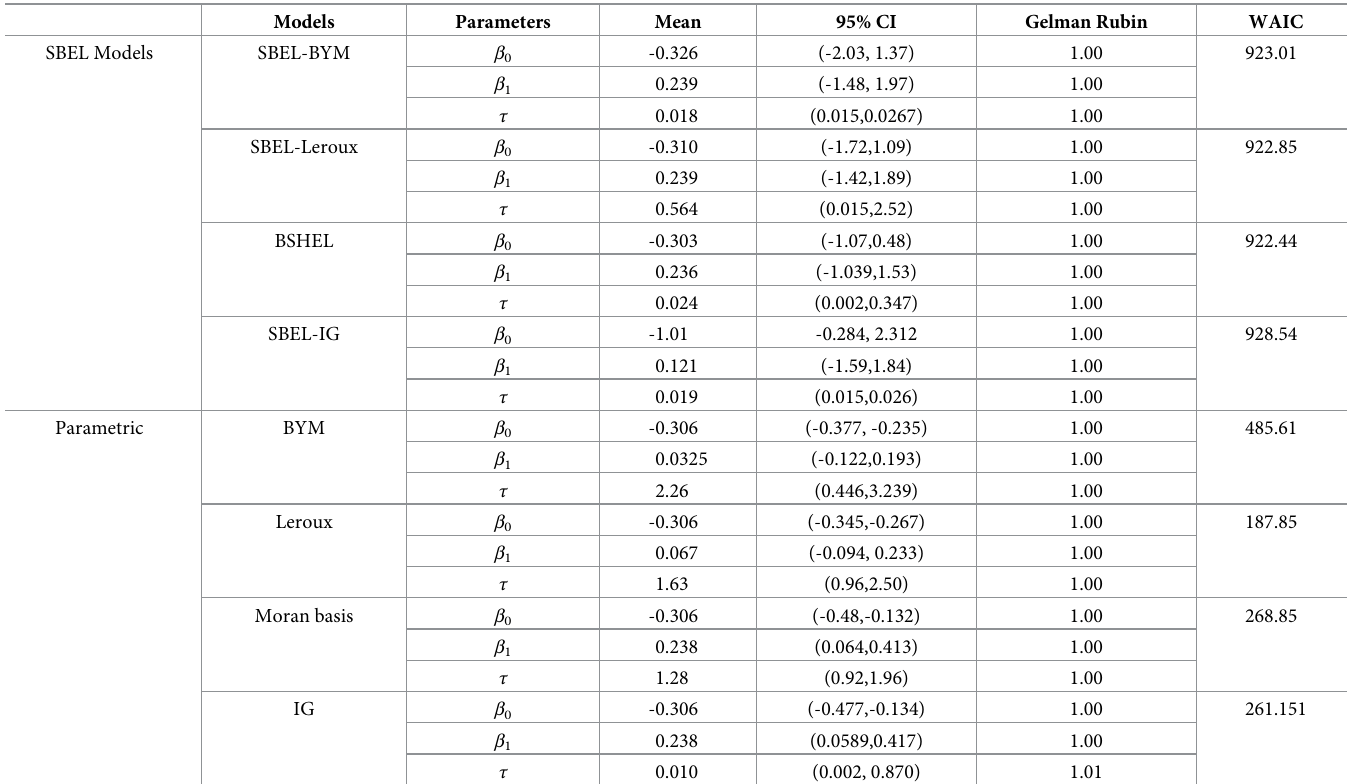
Table 2. Posterior summaries of regression coefficients ( β ) and precision parameter ( τ ) for North Carolina SIDS data using SBEL and Bayesian parametric